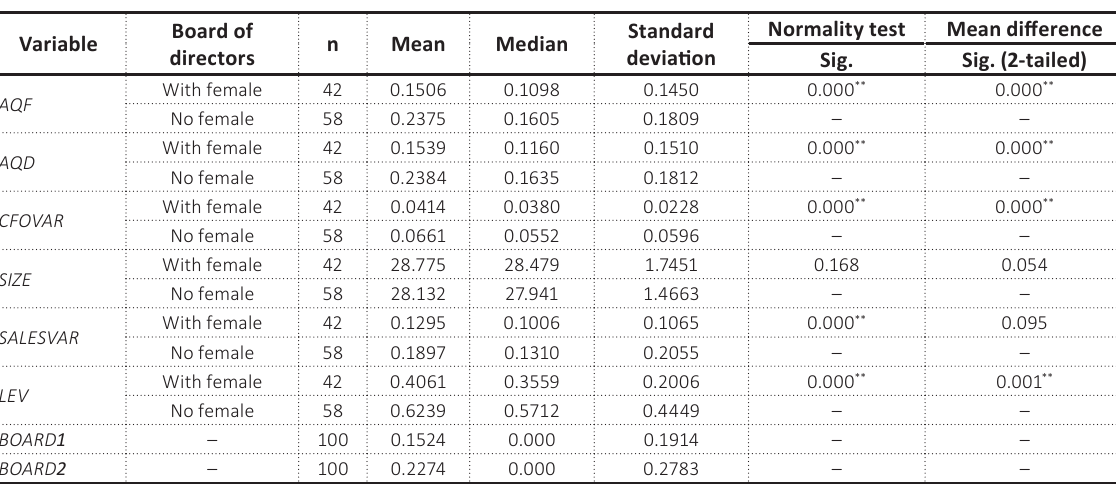
Table 2. Descriptive statistics (non-dummy)